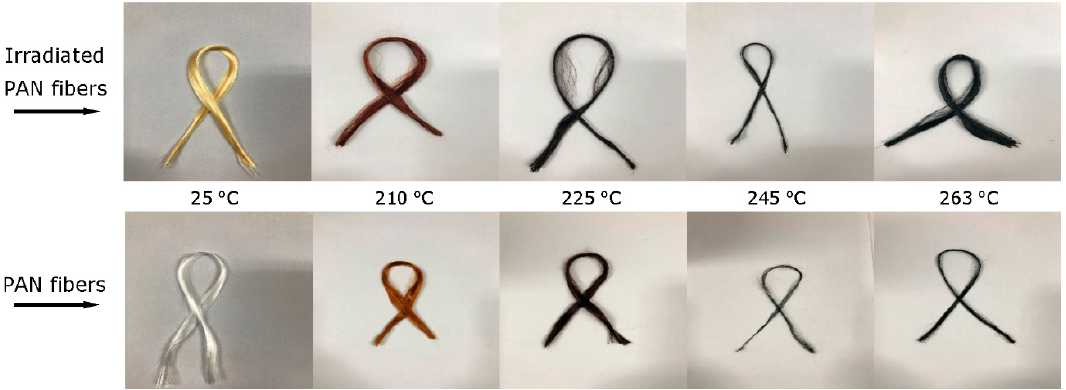
Figure 3. Photographs showing the color change of PAN and irradiated PAN fibers during different stages of stabilization.